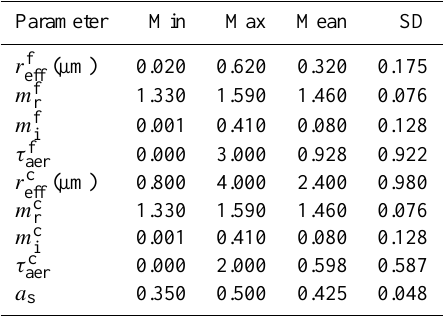
Table 3. Minimum, maximum, mean and standard deviation of the aerosol parameters used to generate the synthetic data set for this study. Please refer to Table 2 for the meaning of the symbols in the first